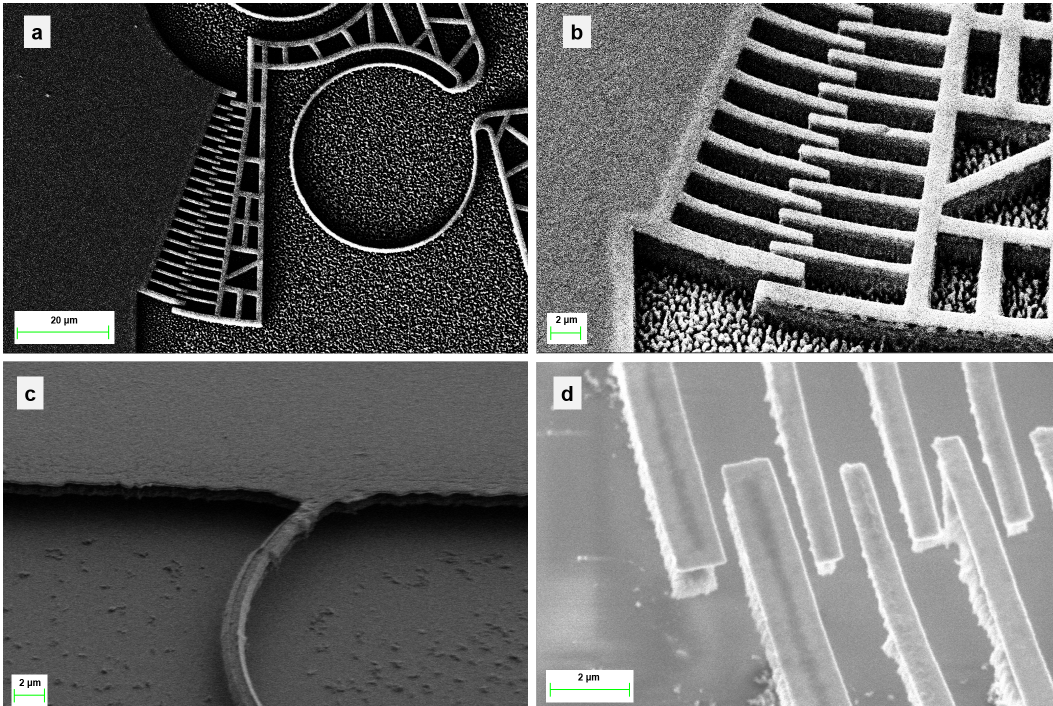
Figure 10. SEM pictures of the nano comb-drive during its fabrication process: top view of the whole patterned device (a) with a 30 ◦ tilted enlargement on the comb-drive fingers (b), 45 ◦ tilted view of an anchored flexure hinge (c) and fingers (d) released from the glass substrate and suspended.These images were taken with an accelerating voltage (EHT) of 10kV, 10kV, 2kV and 5kV respectively; a magnification of 2.63 K X, 8.63 K X, 8.00 K X and 22.81 K X respectively; a working distance of 5.5mm, 10mm, 5.9mm and 10.0mm respectively and a beam current of 10pA